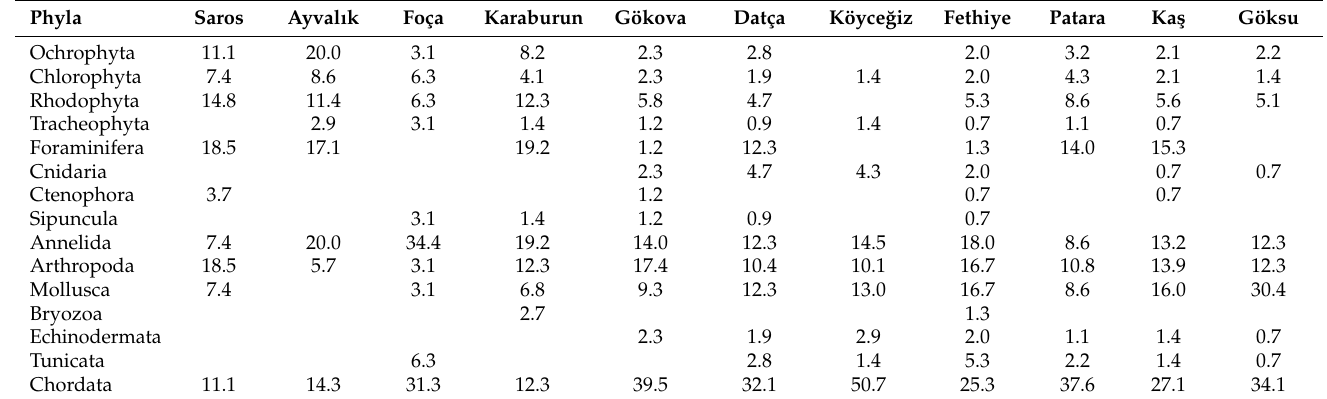
Table 2. Percentage distribution of alien species phyla in Turkish